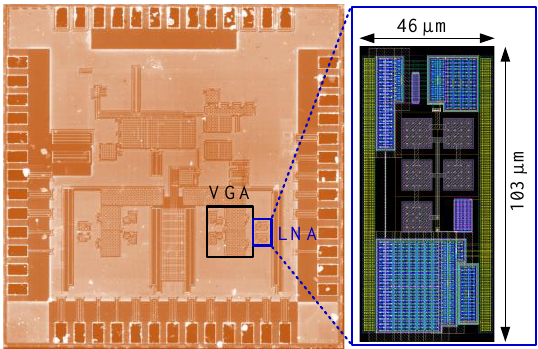
Figure 15. Die photo of the ultrasound front-end.